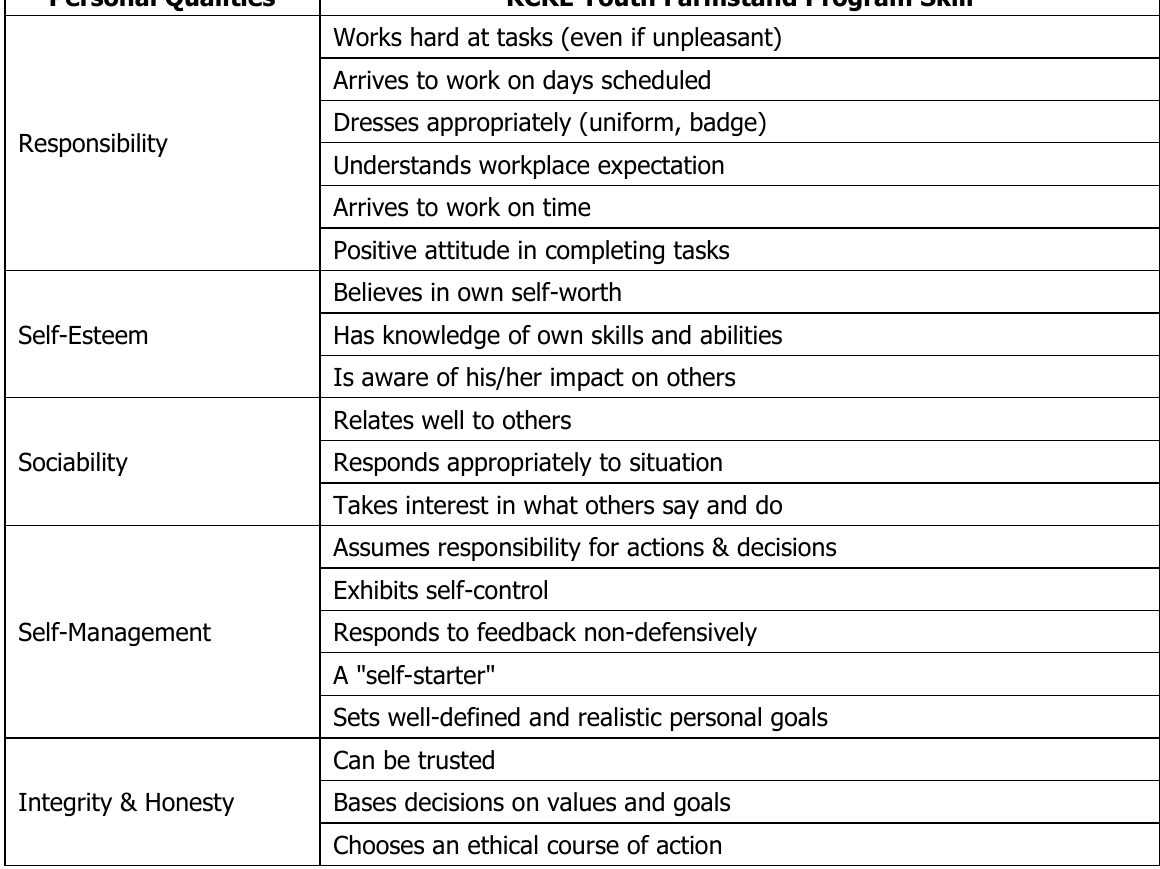
Example of Matching Program Skills to SCANS Skills and